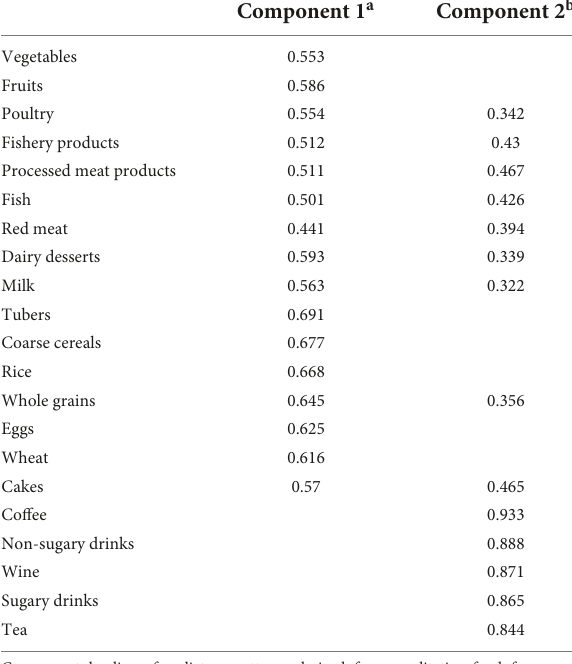
TABLE 1 Component loadings for dietary